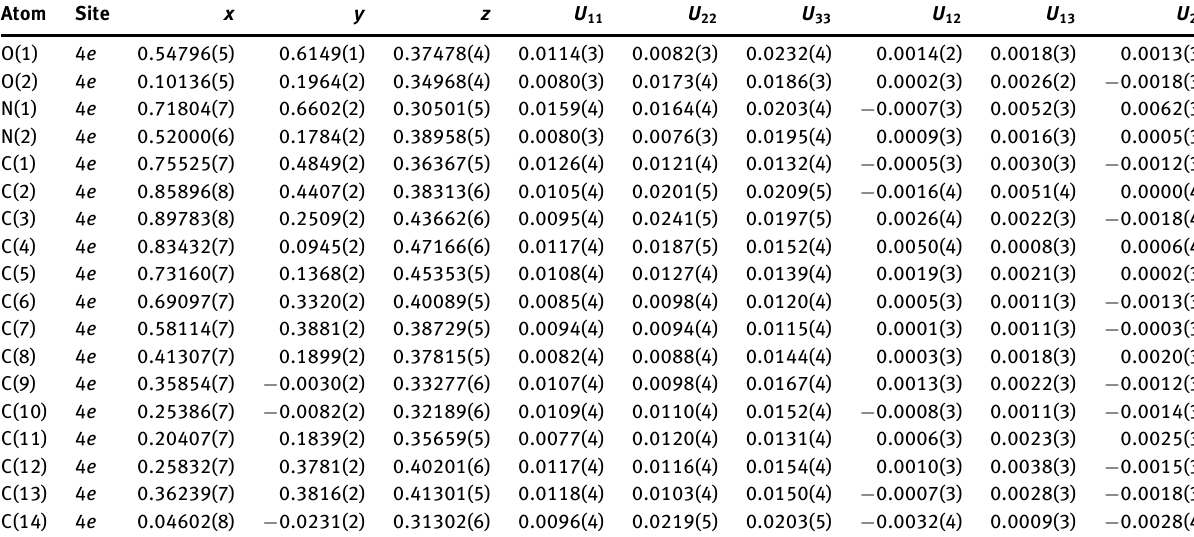
Table 3: Atomic displacement parameters (Å 2